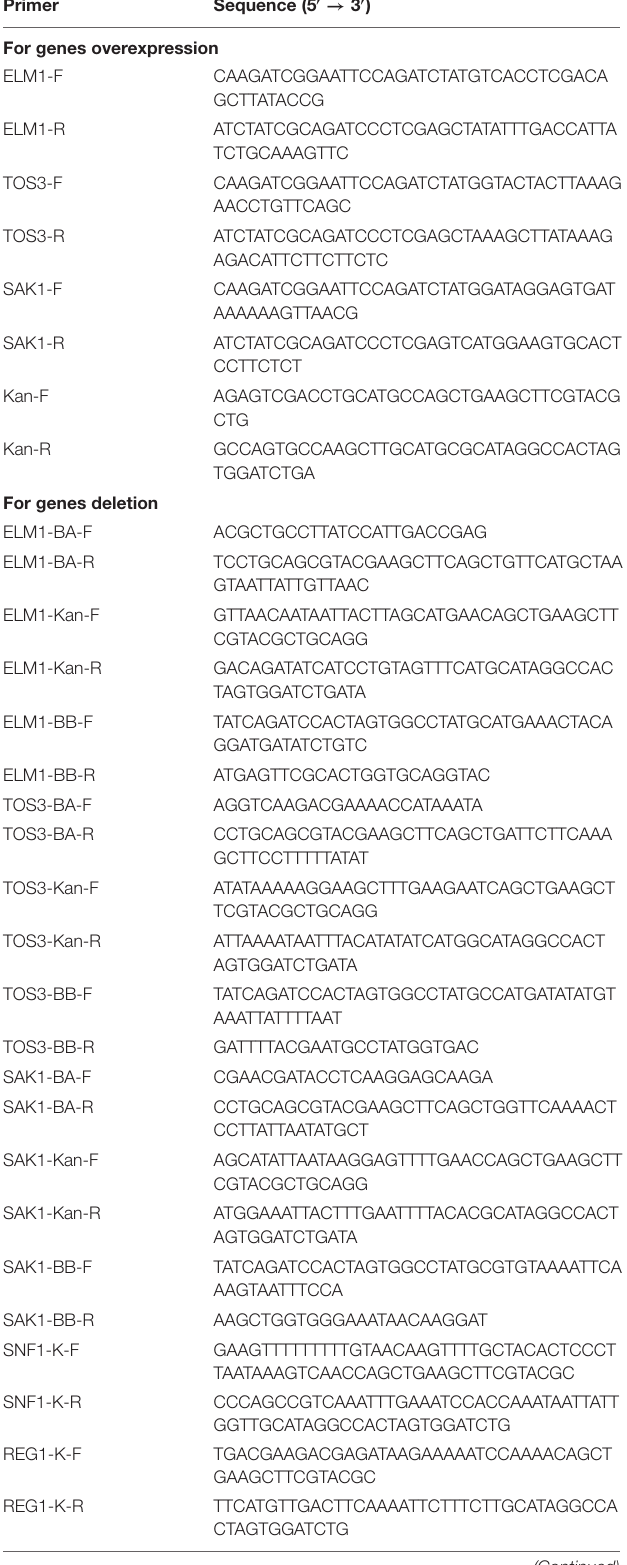
TABLE 2 | Primers used in the present study. Primer Sequence (5 (cid:48) → 3 (cid:48)